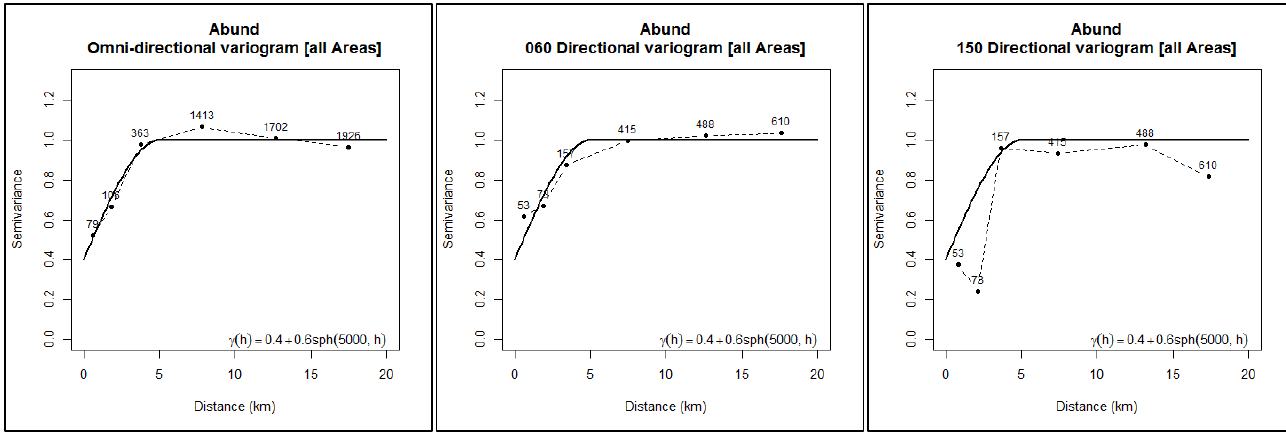
Figure 28. Omni-directional and 060 ◦ and 150 ◦ directional variograms for abundance. Source [12]. Table 6. Model abundance variogram